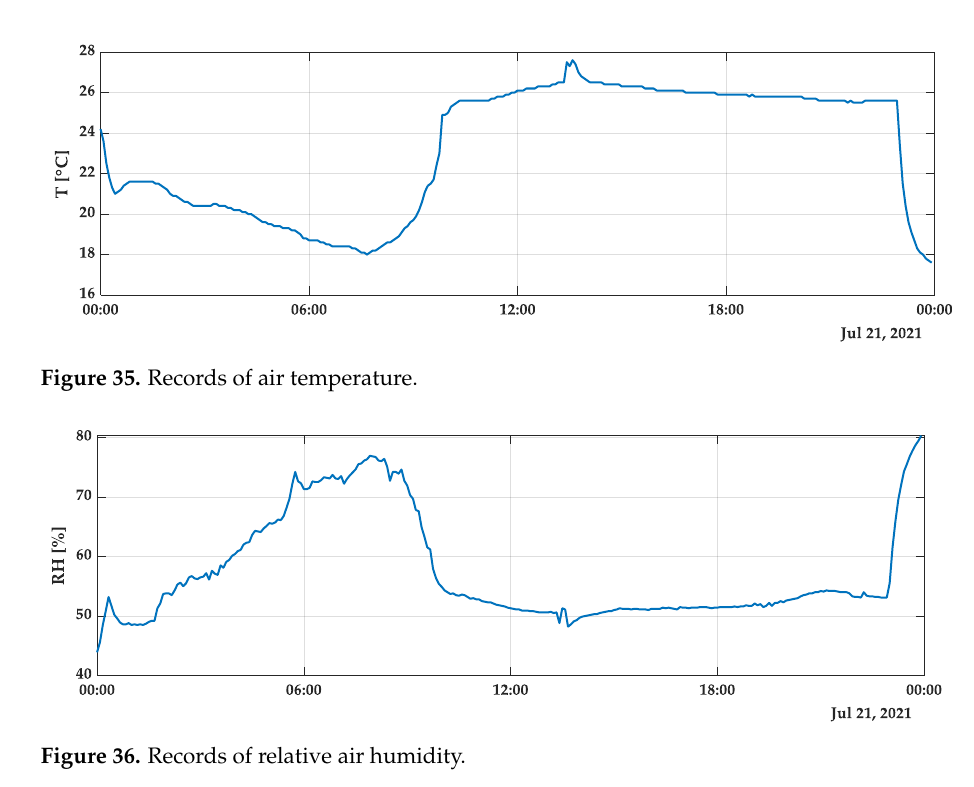
Figure 34. Records of CO 2 levels.